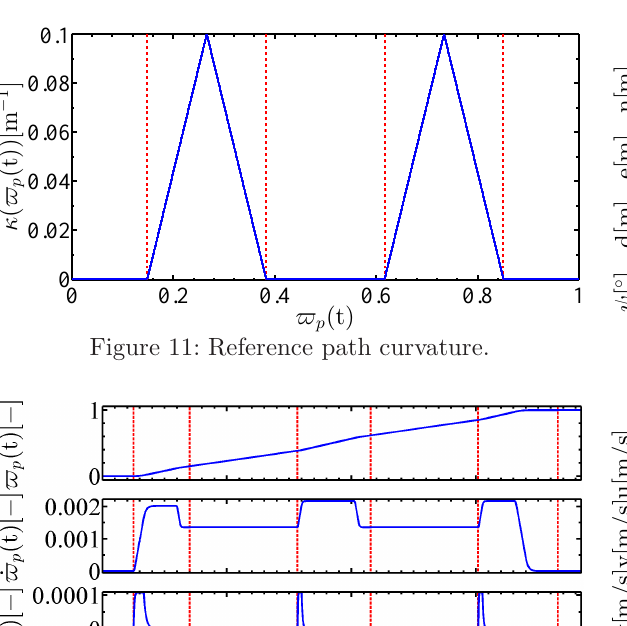
Figure 10: Reference path in the NE-plane.